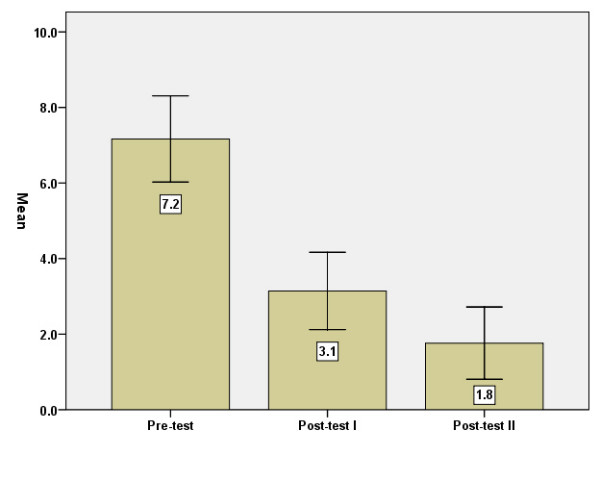
GHQ-12 points, means, before = baseline (I), immediately after (II) and three months after (III) the intervention. Error Bars: +/- 1.96 SE.